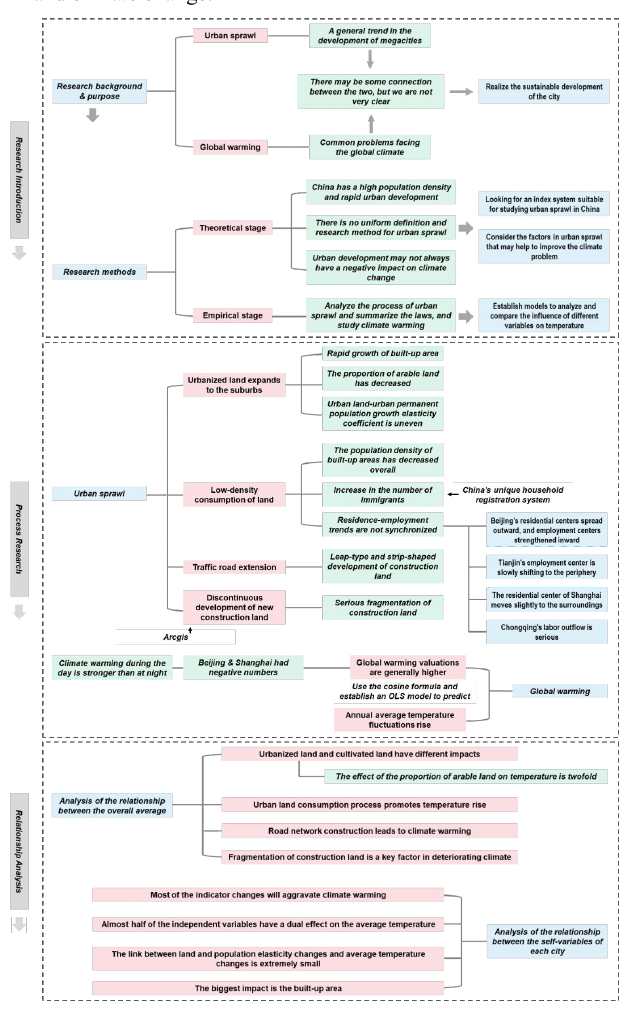
Figure 1 . Research method flow chart.